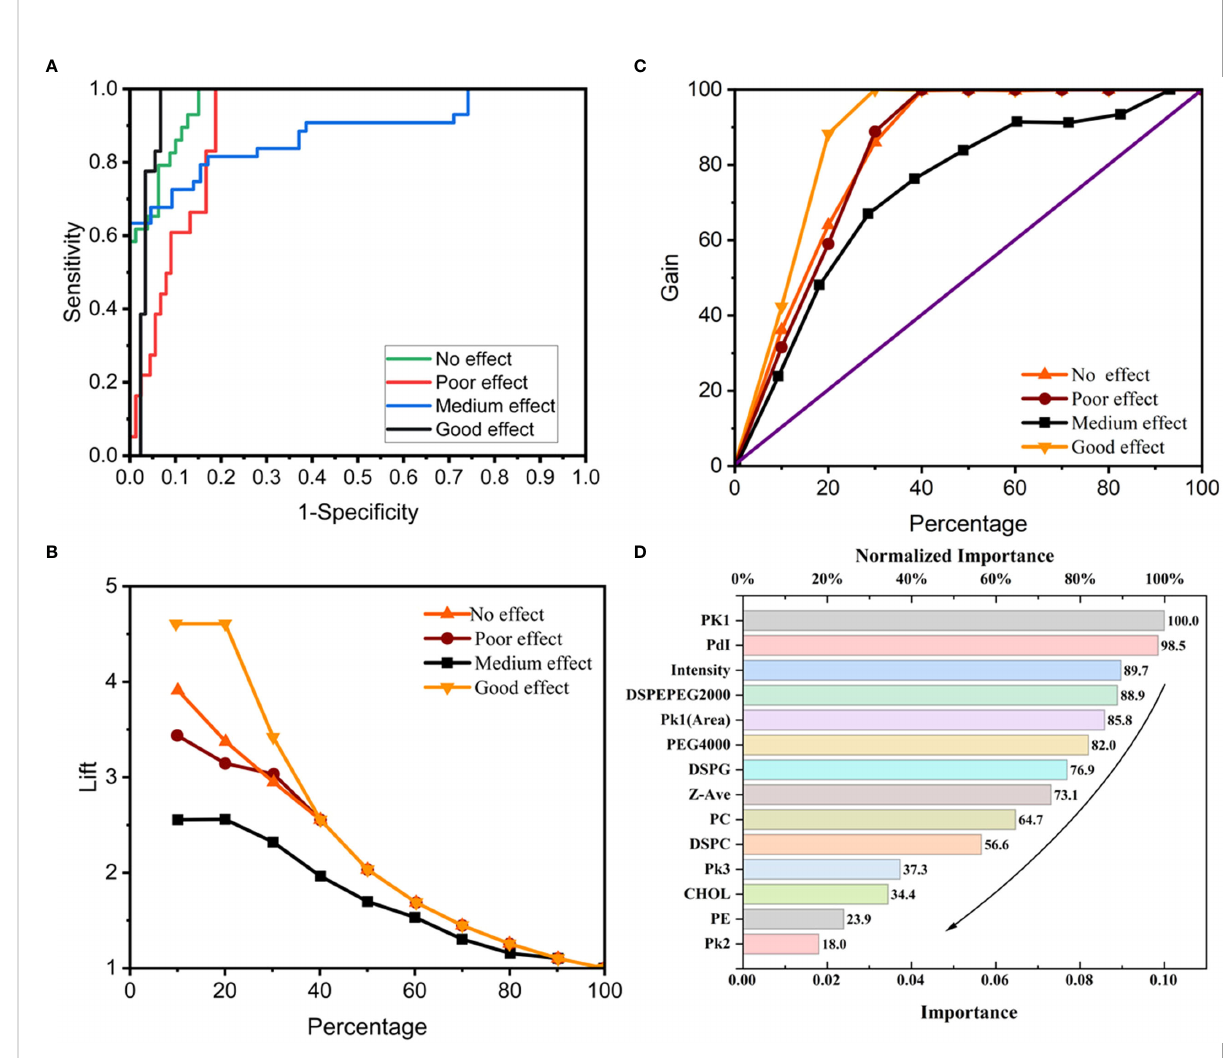
FIGURE 6 The conclusions of Neural network model prediction and calculation. (A) ROC curve of the neural network model; (B, C) Percentage graph of the neural network model. (B) shows that the data are gradually converging. (C) shows that the curves of different ultrasound effects gradually approach stable value of Gain; (D) Importance contribution of each index predicted by the neural network